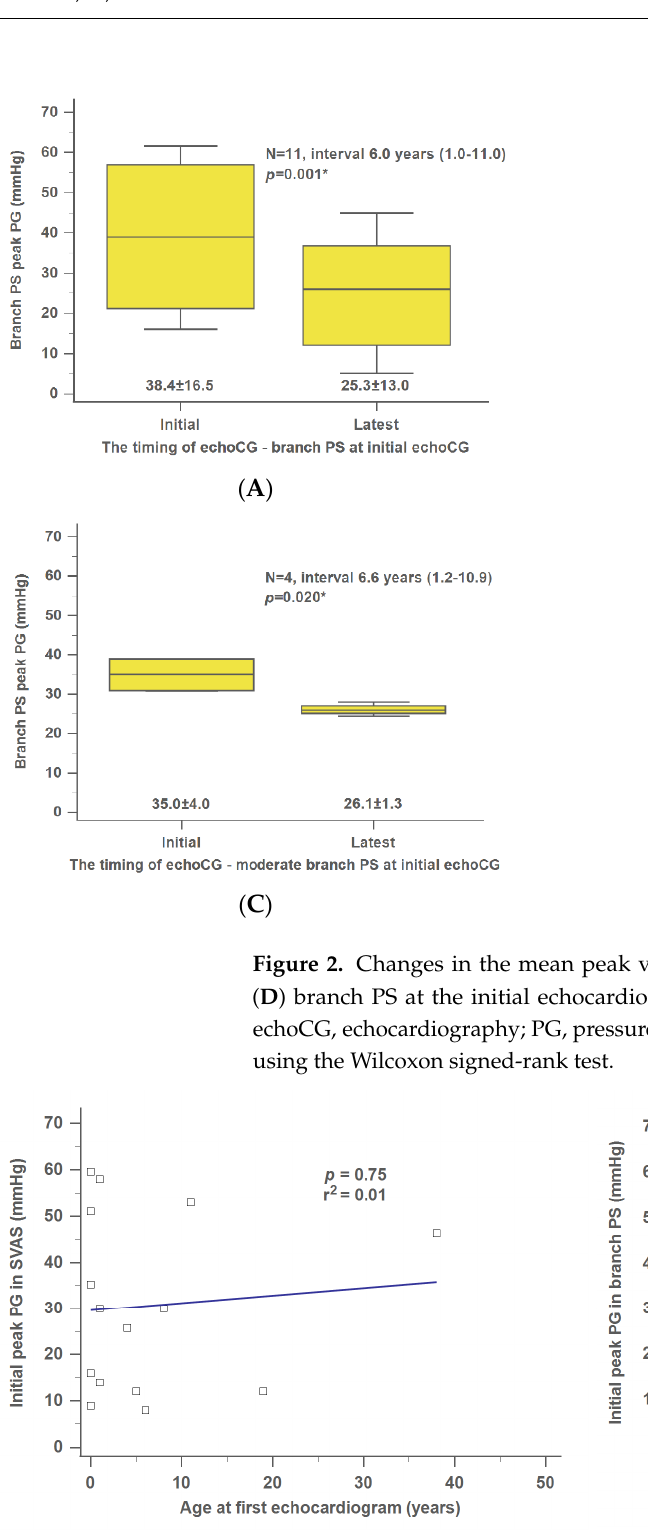
Figure 3. Correlation between the initial peak PG and age at first echocardiogram in ( A ) SVAS, and ( B ) branch PS. PG, pressure gradient; SVAS, supravalvular aortic stenosis; PS, pulmonary stenosis. Figure 4A,B show that the last degree of SVAS was positively correlated with age at last echocardiogram (Figure 4A) or the duration of follow-up (Figure 4B). However, no significant differences were noted ( p = 0.88, the age at last echocardiogram; p = 0.61, the duration of